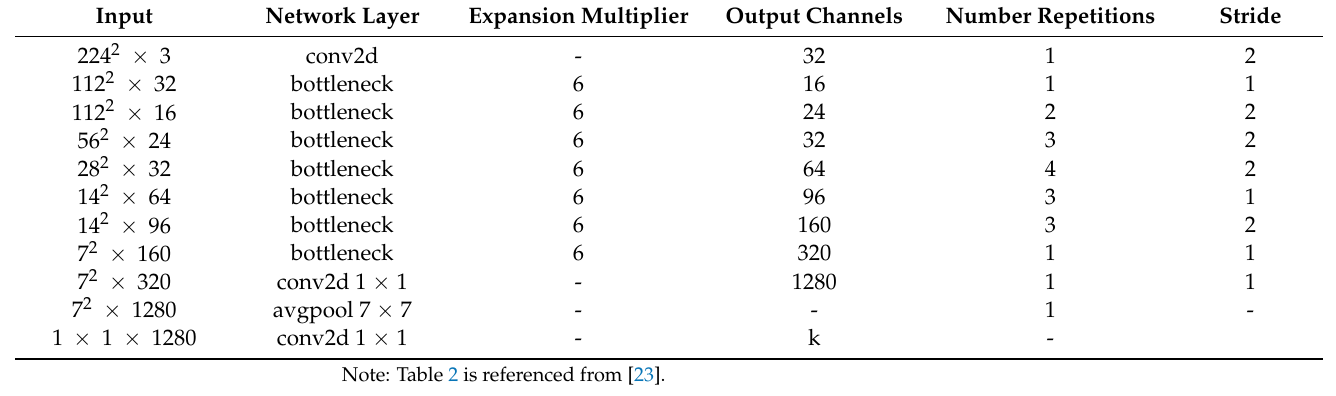
Table 2. MobileNetV2 network architecture.